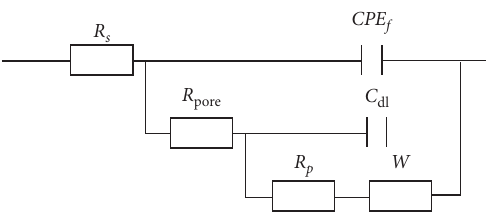
Figure 11: Equivalent circuit used to evaluate the EIS data presented in Figure 10. Table 4: Fitting results of the equivalent circuit obtained by fitting the EIS data.